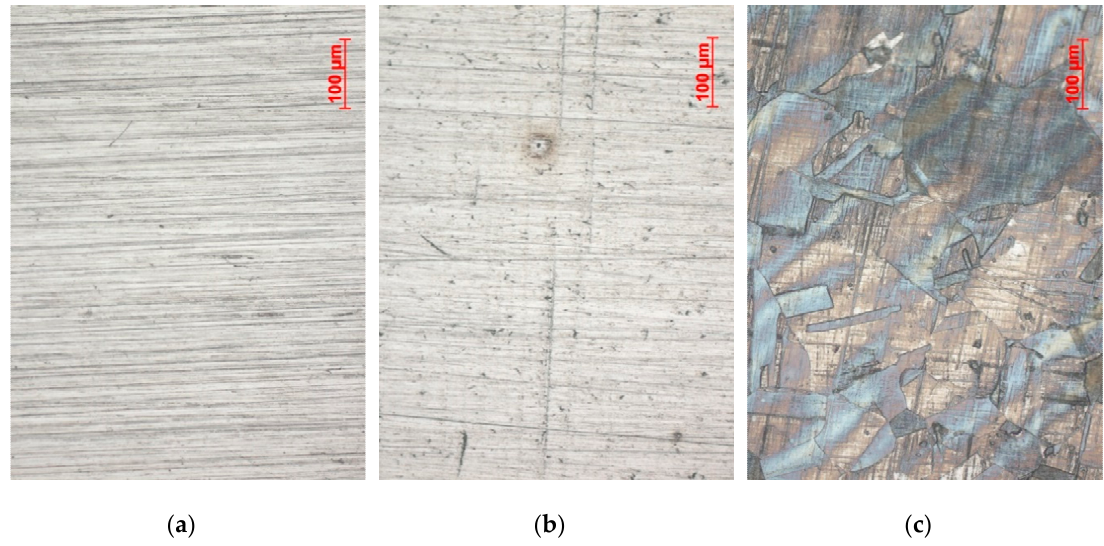
Figure 3. Optical image of corrosive attack of austenitic stainless steel 17Cr12Ni2Mo after exposure to different pH in 30,000 ppm Cl − at 30 °C for 24 h, pH adjustment with HCl, ( a ) pH 4: no corrosion, ( b ) pH 3: pitting corrosion, ( c ) pH 0: uniform corrosion.